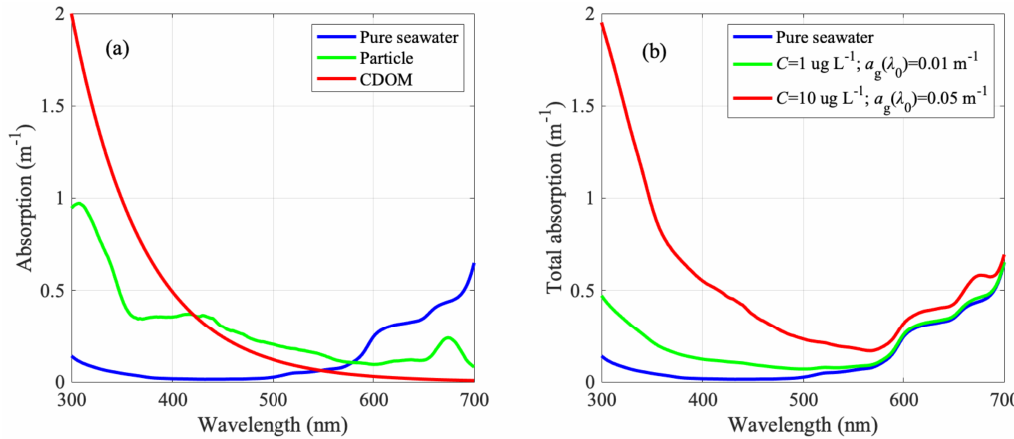
Figure 1. The characteristics of the absorption coe ffi cient in the water: ( a ) Absorption coe ffi cients of pure seawater [34], Colored Dissolved Organic Matter (CDOM) and particles [27,28,32,35]; ( b ) total absorption under di ff erent C and a g ( λ 0 )